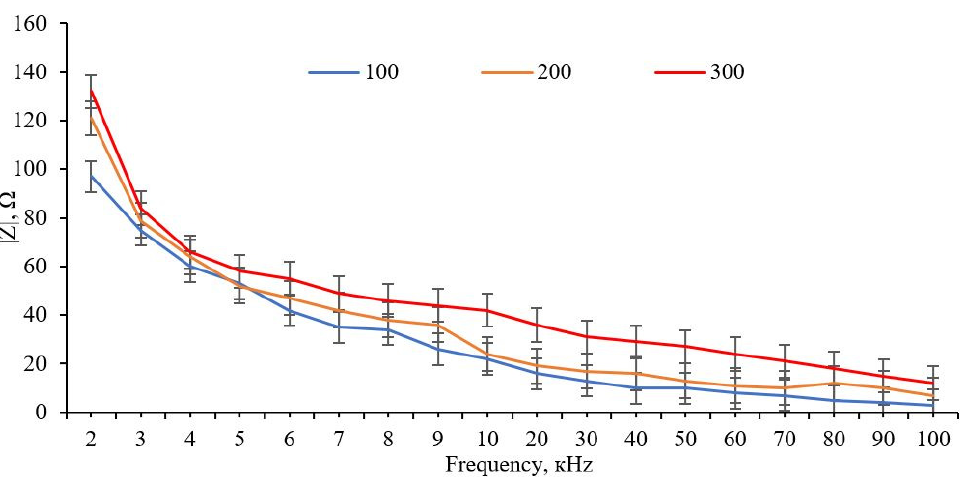
Figure 6. Dependence of the impedance modulus on the frequency for different distance between the electrodes, taking into account the parasitic capacitance (4 months after the grafting; pear tree diameter of 12 mm).